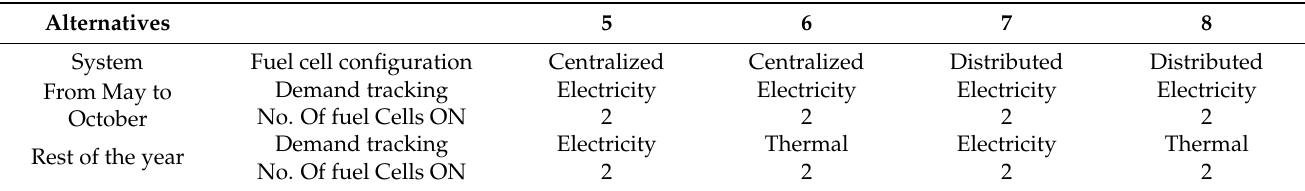
Table 8. Summary of the main differences of the 1 MW electricity CHP systems developed for further comparison.